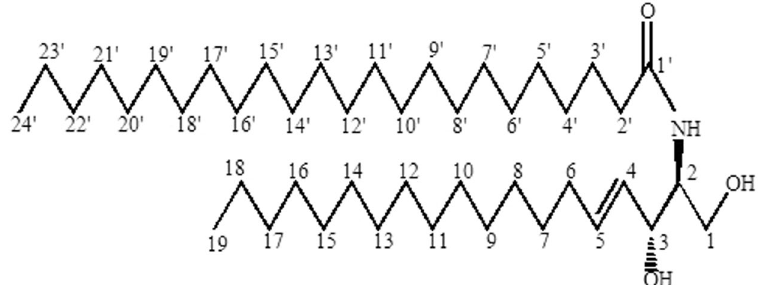
Figure 3. Compound B (1,3-dihydroxy-2-tetracosanoylamino-4-(E)-nonadecene).